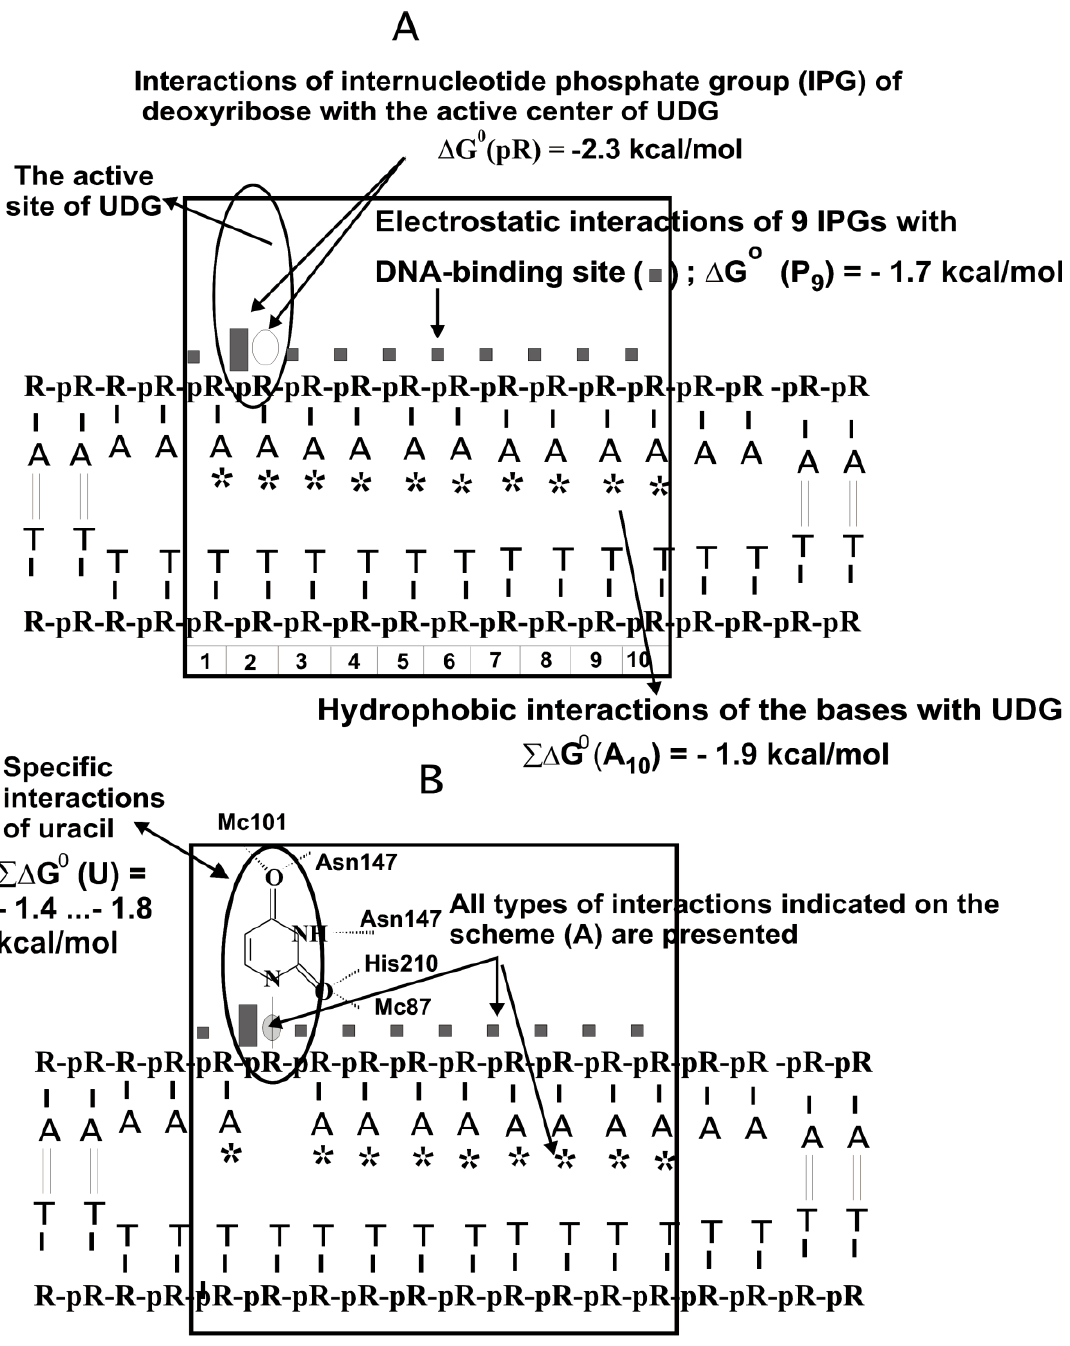
Figure 4. The thermodynamic model of human UDG interaction with unspecific ( A ) and specific DNA containing dU nucleotide unit ( B ). The ∆ G ◦ value characterizing of five specific hydrogen bonds between UDG and U-base was evaluated to be approximately –1.3 kcal/mol ( B ), while unspecific electrostatic ( ■ ) and hydrophobic ( ★ ) interactions provide G° = −5.9 kcal/mol ( A ) [27].